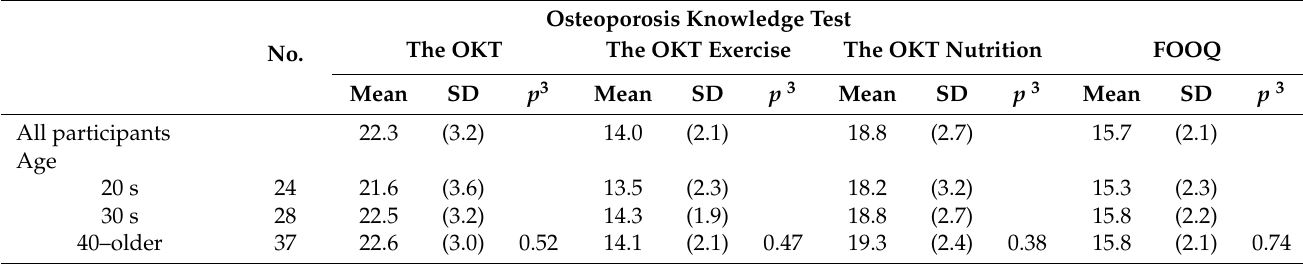
Table 3. The mean scorers of osteoporosis knowledge scores according to potentially associated